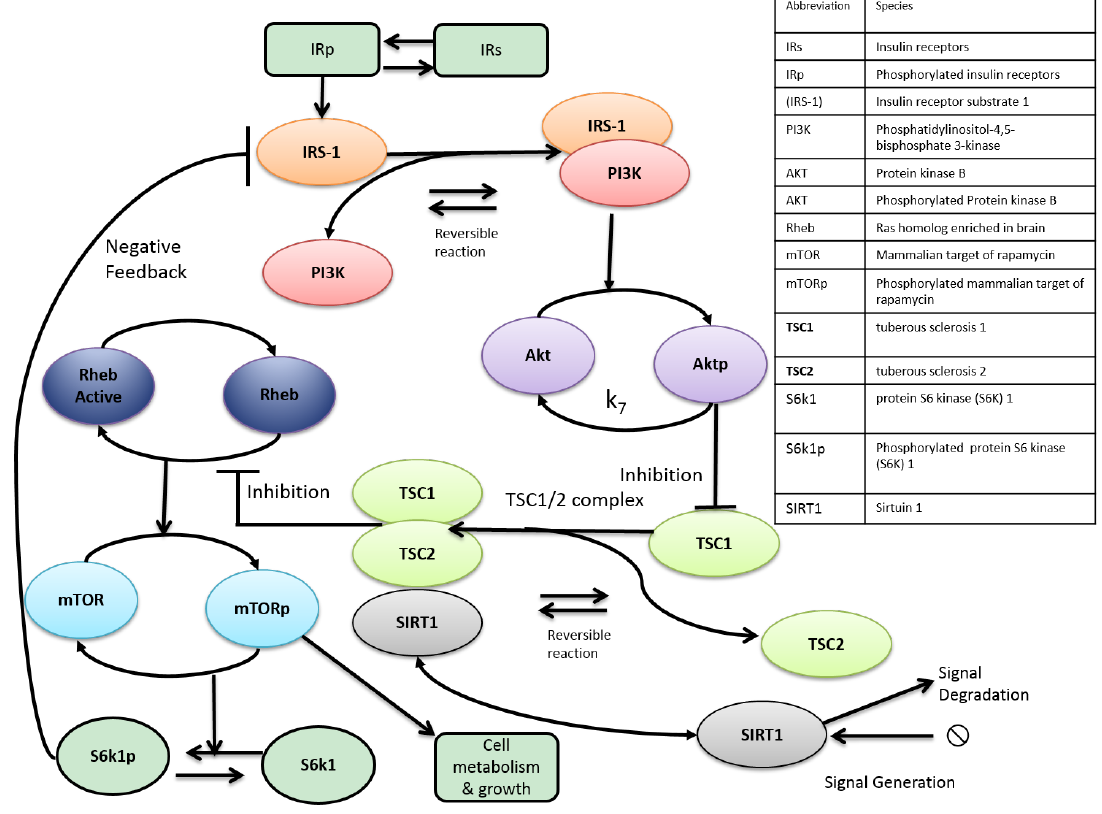
Figure 3. Proposed reduced model of SIRT1 and mTOR interaction based on Ghosh et al. (2010) [31]. Insulin binds to IRs resulting in autophosphorylation. IRs can be phosphorylated or unphosphorylated [123]. The active IR induces the phosphorylation of IRS-1 via the activity of protein tyrosine kinase. This signal depends on phosphorylated IR. IRS1p docks with PI3-kinase. This results in the formation of the IRS-1/activated PI3-kinase complex (IRS1pPI3). Dissociation of the complex is dependent on IRS1pPI3. Phosphorylation of Akt phosphorylated Akt. The TS1/2 complex inhibits the conversion of inactive Rheb to active Rheb (Rheb-GTP). RhebA activates mTORC1. Activation of mTORC1 affects S6K,